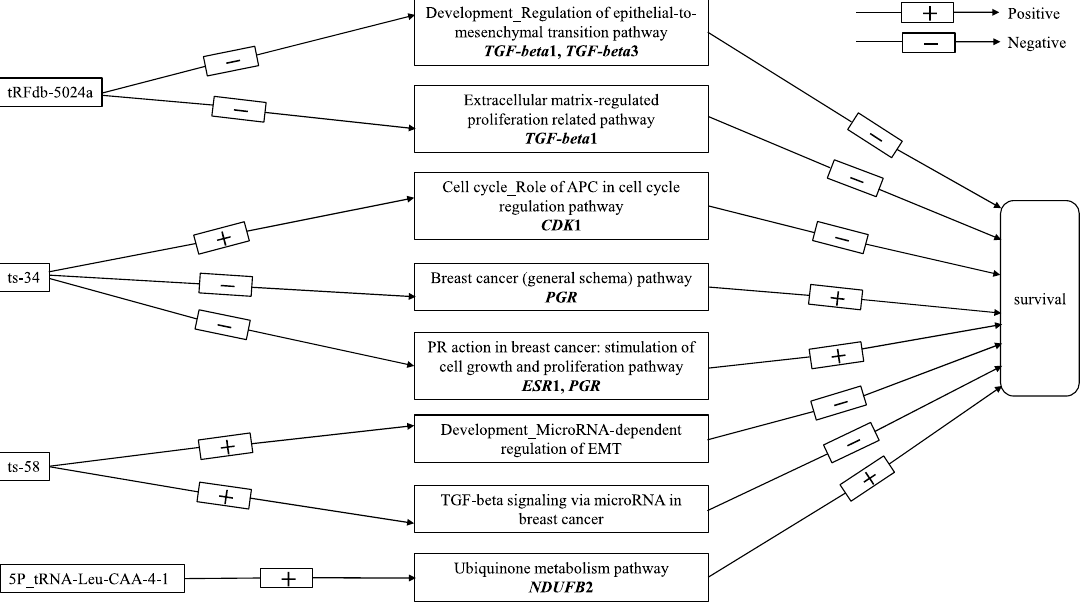
Figure 5. A schematic pathway diagram of the potential molecular mechanisms of vital-associated tRFs in breast cancer.